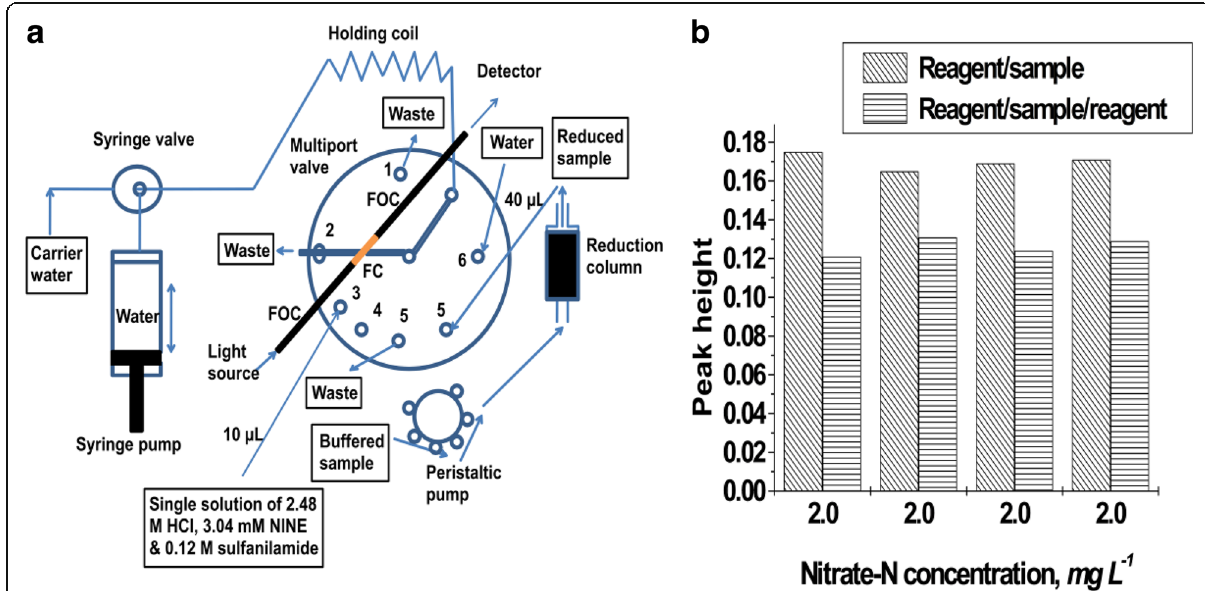
Fig. 1 a Optimized manifold for SI analysis of nitrate-N in stopflow mode. b Stacking of sample and reagent zones in the holding coil. FC flowcell, FOC fiber optic